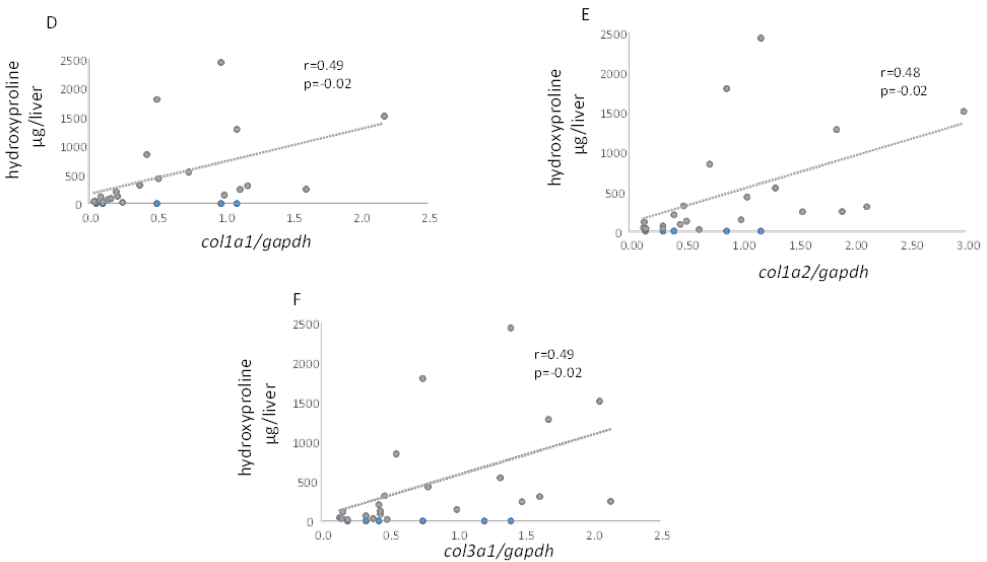
Figure 3. Hepatic col1 and col3 in NASH with Fibrosis. Increased hepatic transcriptomic expression of col1a1 ( A ), col1a2 ( B ), and col1a3 ( C ) in the FFD cohort; *, p<0.05 vs. sham. Hepatic col1a1 ( D ), col1a2 ( E ), and col1a3 ( F ) expression each exhibited a direct correlation with liver hydroxyproline content.